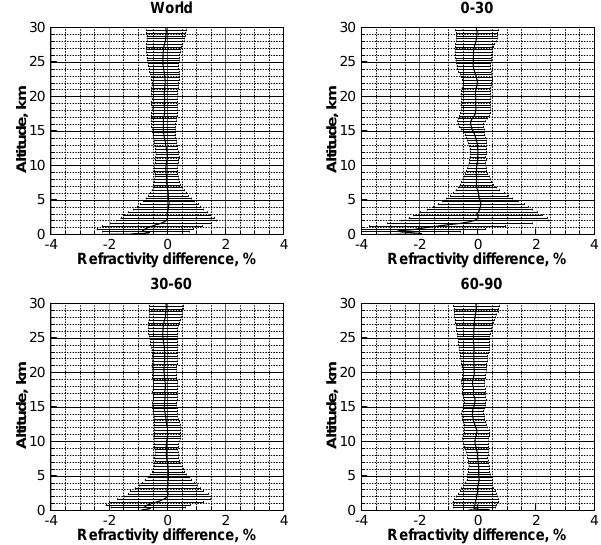
Fig. 6. Statistical comparison of GRAS RS+CL and ECMWF re- Figure 6. Statistical comparison of GRAS RS+CL and ECMWF refractivities for October 3 fractivities for October 2007: the whole globe (“World”), tropics 2007: the whole globe (‘World’), tropics (‘0–30’), mid-latitudes (‘30–60’), and polar latitudes 4 (“0–30”), mid-latitudes (“30–60”), and polar latitudes (“60–90”). (‘60–90’). 5